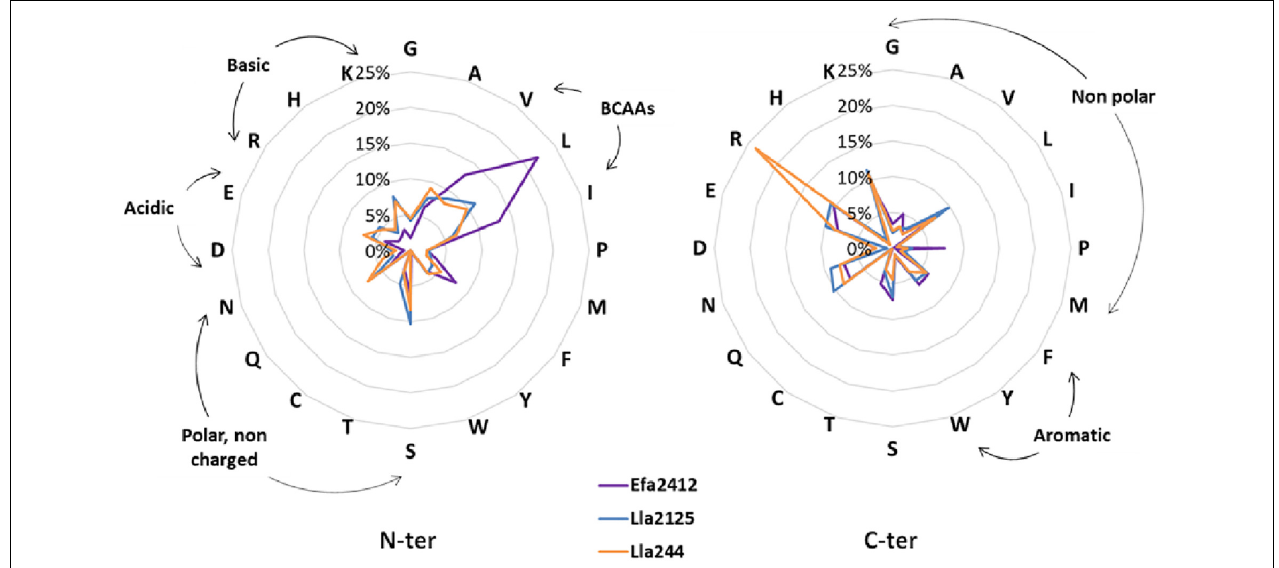
FIGURE 7 | Profile of the cleavage sites observed for the three donor strains: amino acid frequencies at N-ter and C-ter positions of all the peptides produced by the strains Efa2412, Lla2125, and Lla244, independently on the parental proteins and the time. n = 1401 for Efa2412, n = 507 for Lla2125, and n = 829 for Lla244. BCAAs = branched-chain amino